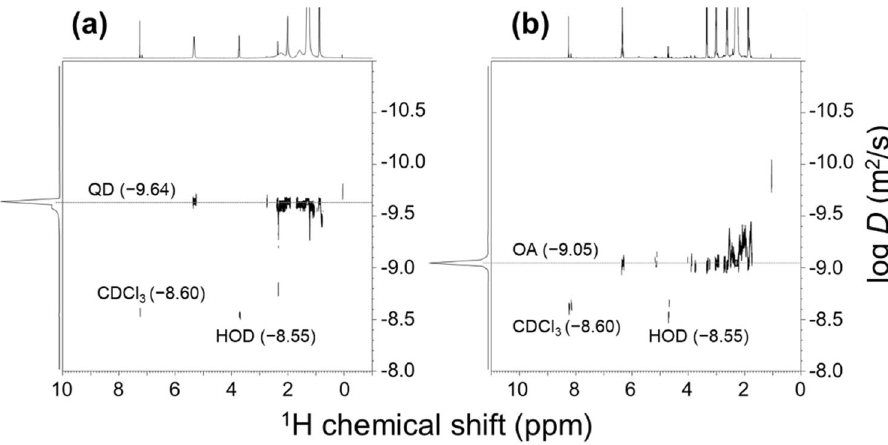
Figure 4. 2D-DOSY NMR spectra of InP/ZnS-OA: ( a ) before and ( b ) after treatment with 50 μL of H 2 O 2 and CDCl